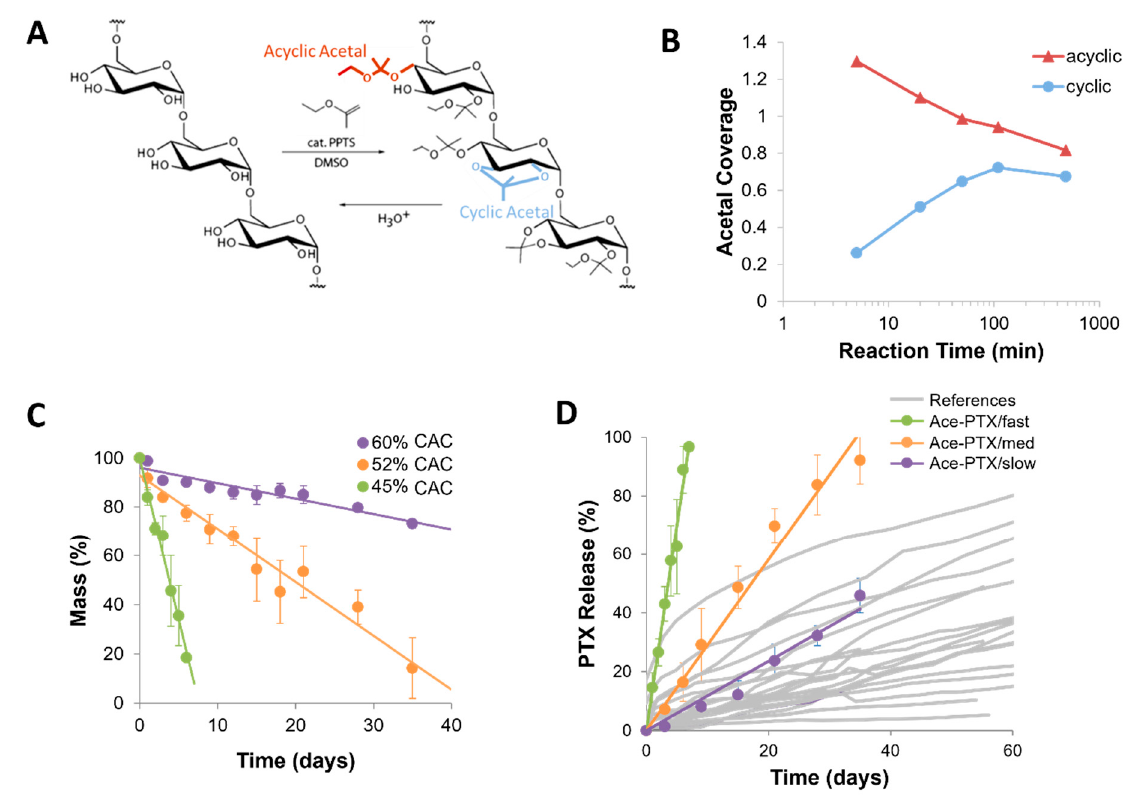
Figure 3. ( A ) Chemical synthesis reaction for converting dextran to Ace-DEX. ( B ) Reaction kinetics demonstrating the increase in cyclic acetal composition over time. Slightly modified and reproduced with permission from [94]. ( C ) Effect of cyclic acetal coverage (CAC) on degradation rate of Ace-DEX scaffolds. ( D ) Images of published in vitro release curves were analyzed using Automeris WebPlot Digitizer. Data were exported to excel and plotted together on the same x and y axis for ease of viewing. Grey lines are PTX release from polyester implants from references [28–30,77,78,95,96]. Red, green, and blue lines are PTX released from Ace-DEX scaffolds (Ace-PTX) with varying CAC. ( C , D ) Slightly modified and reproduced with permission from [27,94].